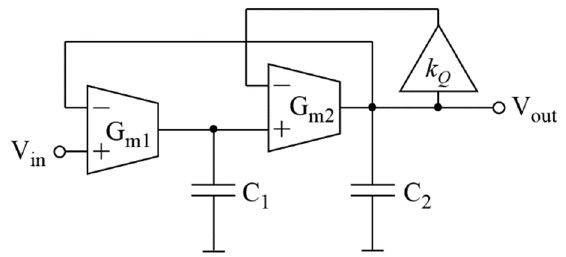
Figure 2. Proposed second-order low-pass filter with independent Q LP -factor tuning (OTA-C structure).